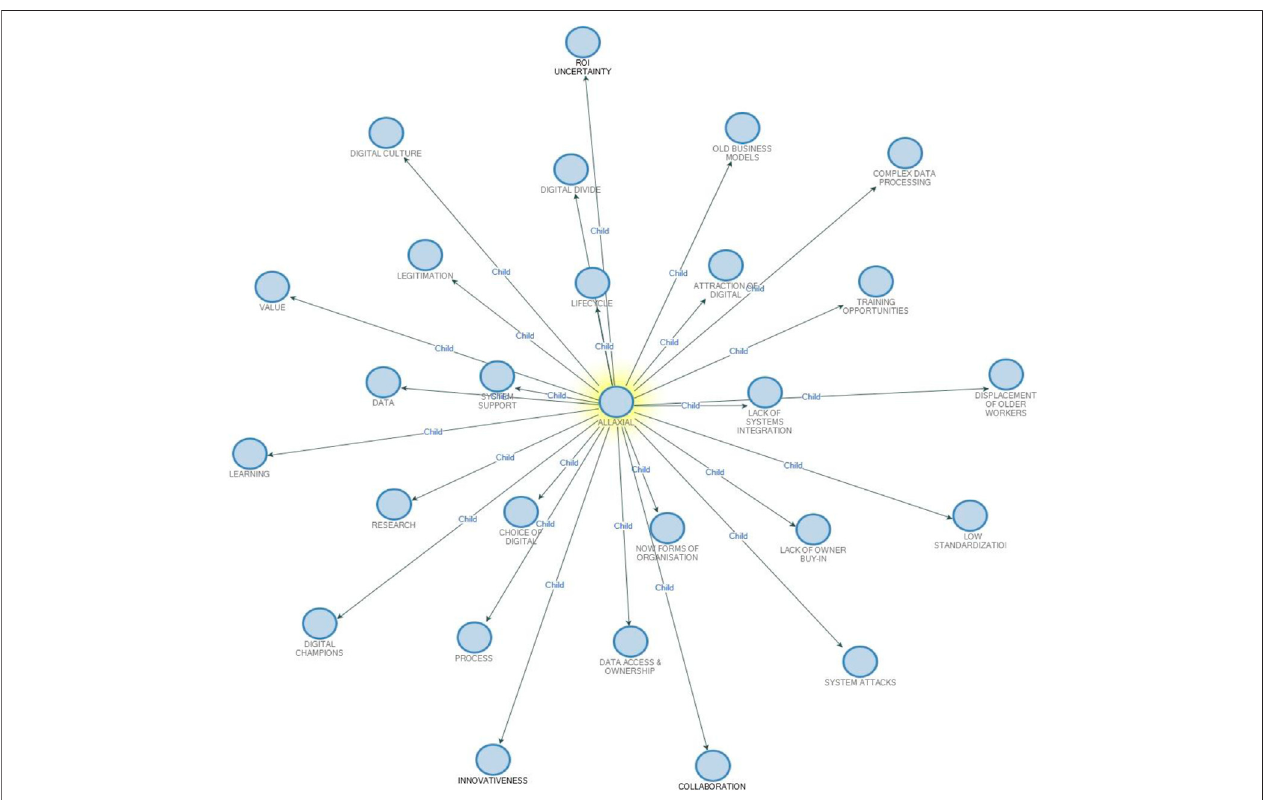
FIGURE 2 | NVivo explore diagram of the second-order